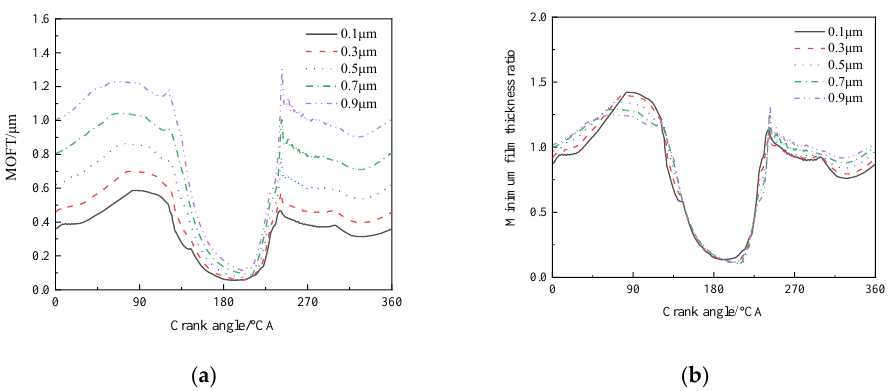
Figure 15. ( a ) Bushing roughness influences MOFT. ( b ) Bushing roughness influences minimum oil film thickness ratio.